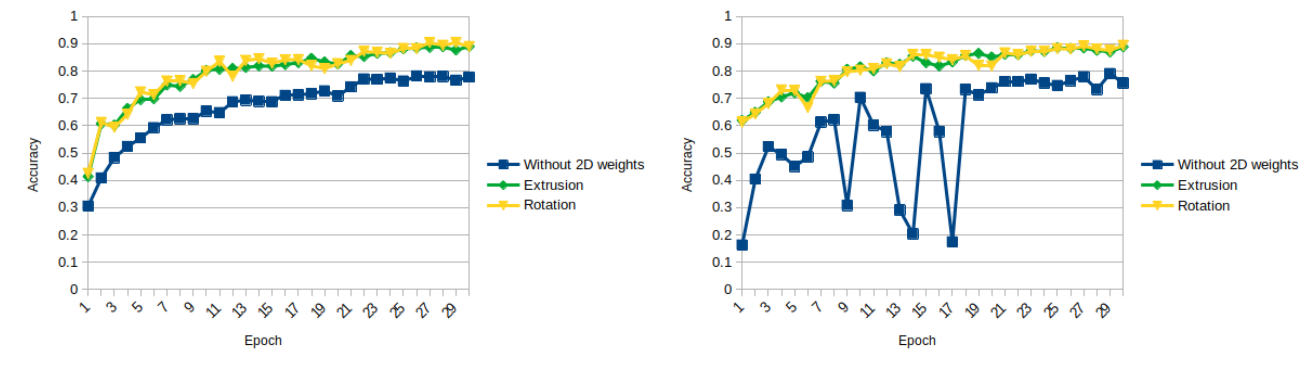
Figure 13. Inception ResNet 3D Loss (Categorical Cross-Entropy).